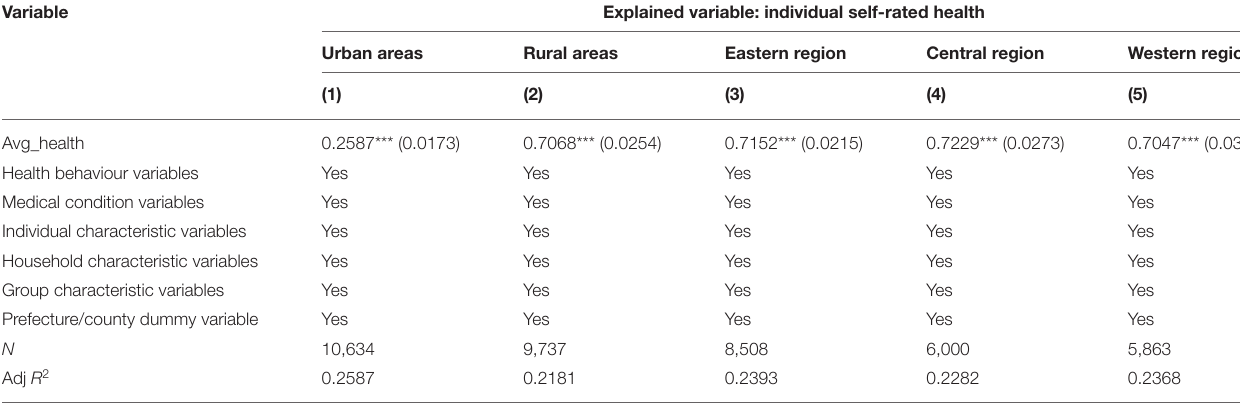
TABLE 6 | Regression results for health contagion among urban and rural areas and different regions.